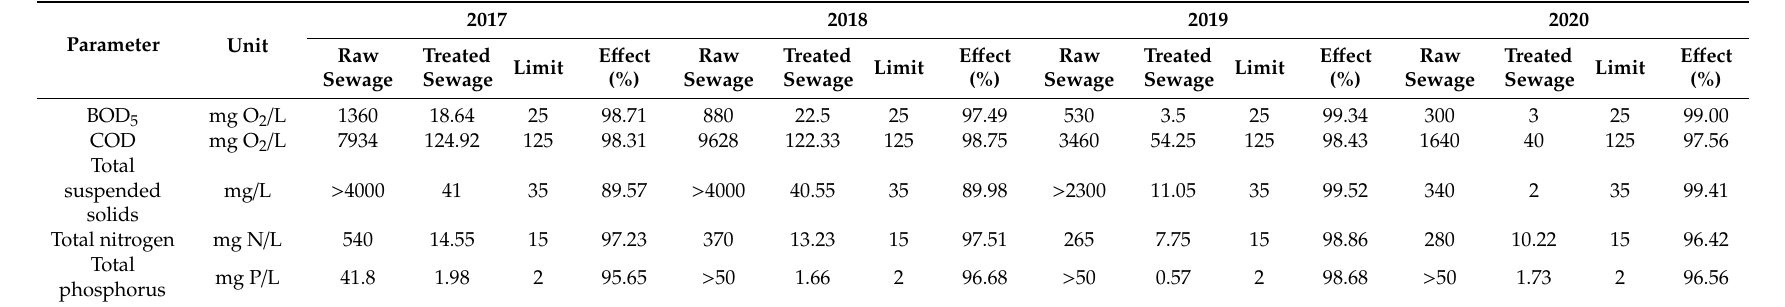
Table 7. Comparison of the values of raw and treated wastewater pollution indicators and treatment e ffi ciency in